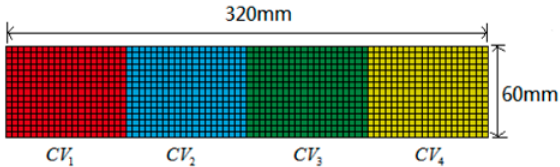
Fig. 6. The mesh model in the flattening